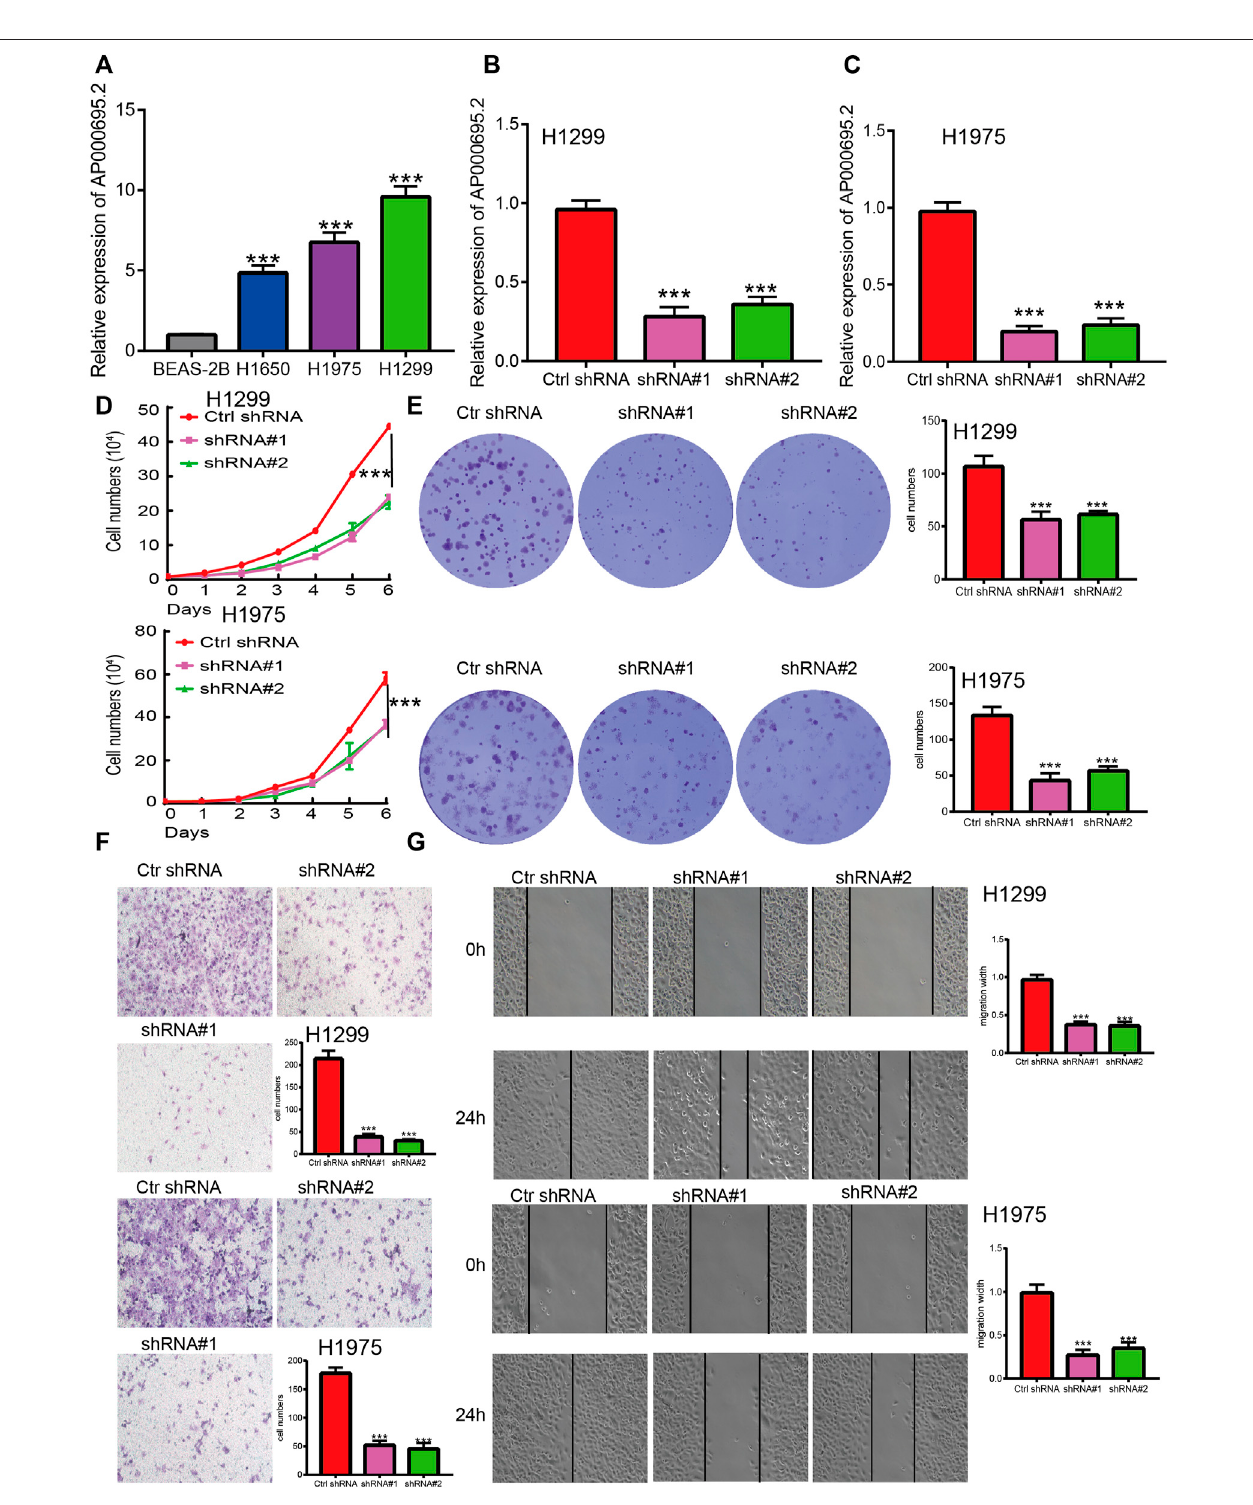
FIGURE 8 | lncRNA-AP000695.2 promotes LUAD cell proliferation, migration, and invasion in vitro . (A) Relative expression level of lncRNA AP000695.2 in lung adenocarcinoma cancerous cell lines, including H1650, H1975, and H1299 examined byreal-time RT-PCR, compared withnormal human bronchialepithelial cell lines: BEAS-2B. (B – C) Establishment of lncRNA-AP000695.2 knockdown cell lines in H1299 and H1975 cells veri fi ed by real-time RT-PCR. (D – E) Knockdown of lncRNA- AP000695.2 signi fi cantly inhibits cell proliferation in H1299 and H1975 cells as measured by BrdU and colony formation. (F – G) Knockdown of lncRNA AP000695.2 dramatically inhibits H1299 and H1975 cells ’ migration ability examined by transwell and wound healing assays. * p < 0.05, ** p < 0.01, and *** p < 0.001.